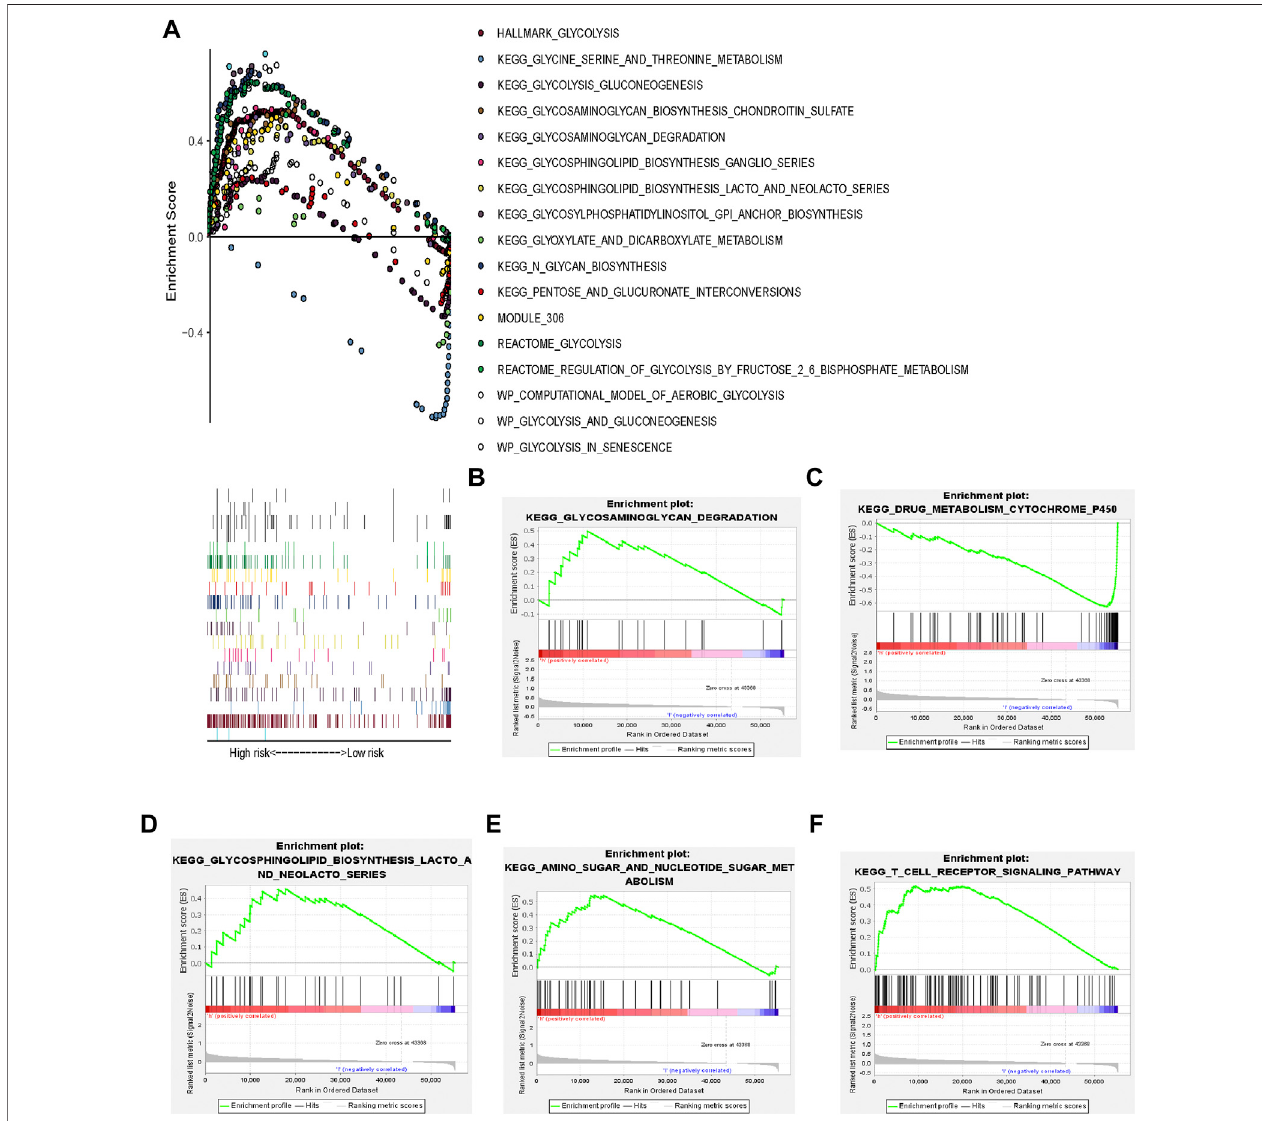
FIGURE 3 | Glycolysis-related gene signature (A) GSEA of 17 pathways; (B – F) KEGG pathways.